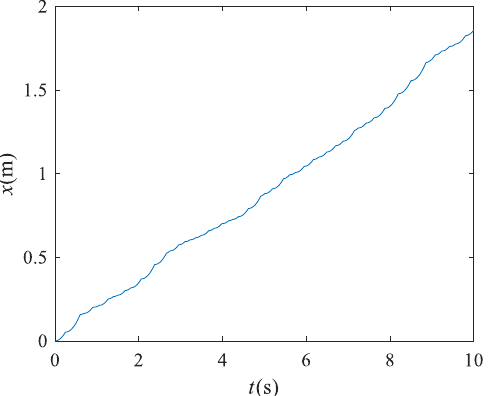
Figure 6. Displacement of the particle at f = 16 Hz and A = 4 mm.